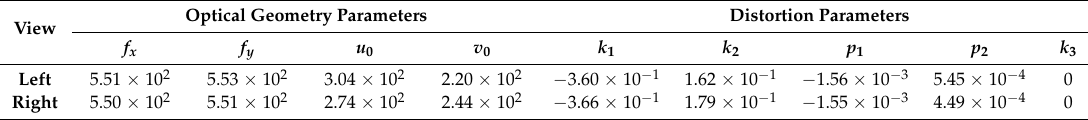
Table 2. Intrinsic parameters of the binocular vision system (in the air, at 1 m distance). View